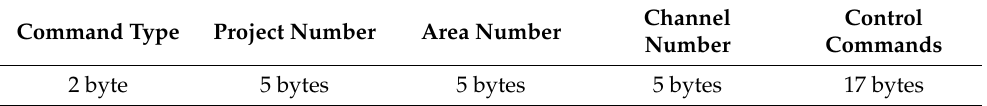
Table 2. Control command